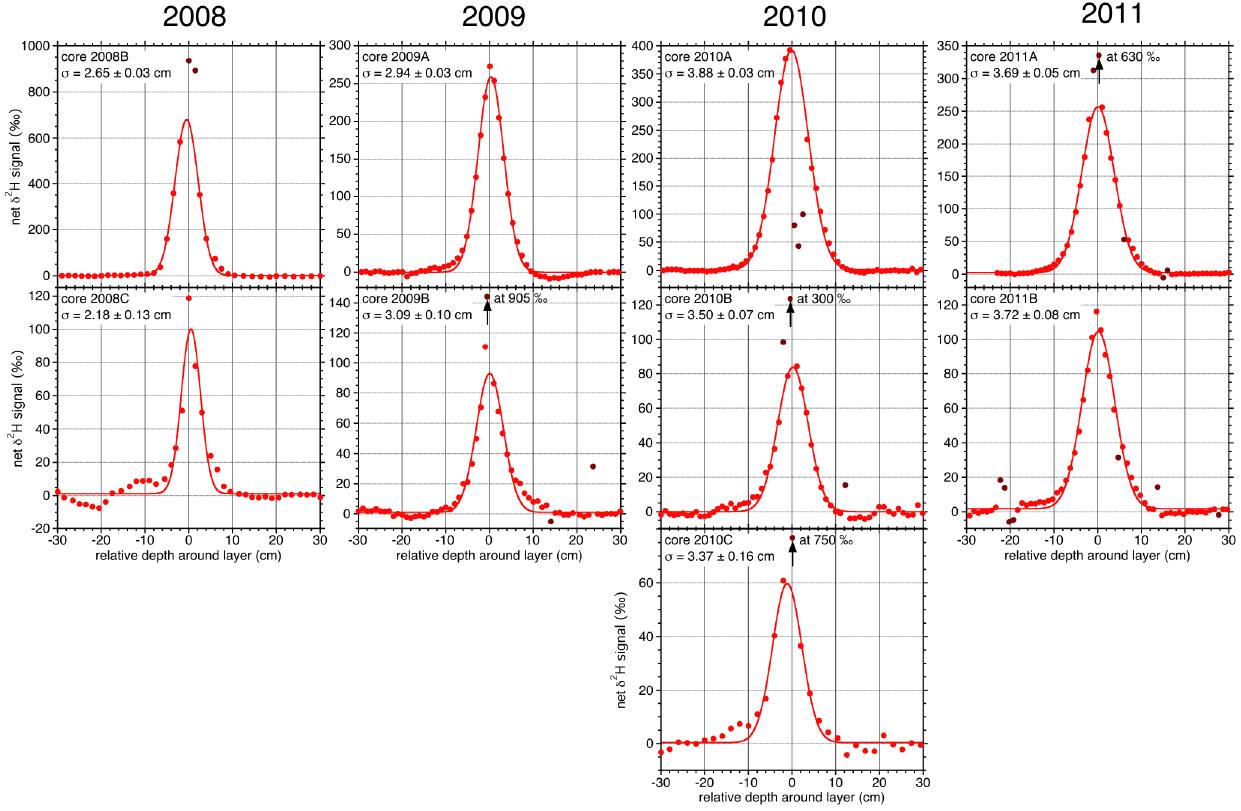
Figure 6. The nine net δ 2 H profiles for the four consecutive years, together with the Gaussian fits. The width of the fit, which is the diffusion length σ , is listed in the plots. The brown circles are measurements discarded from the fit for various reasons (see text). The increase of σ over the years is clearly